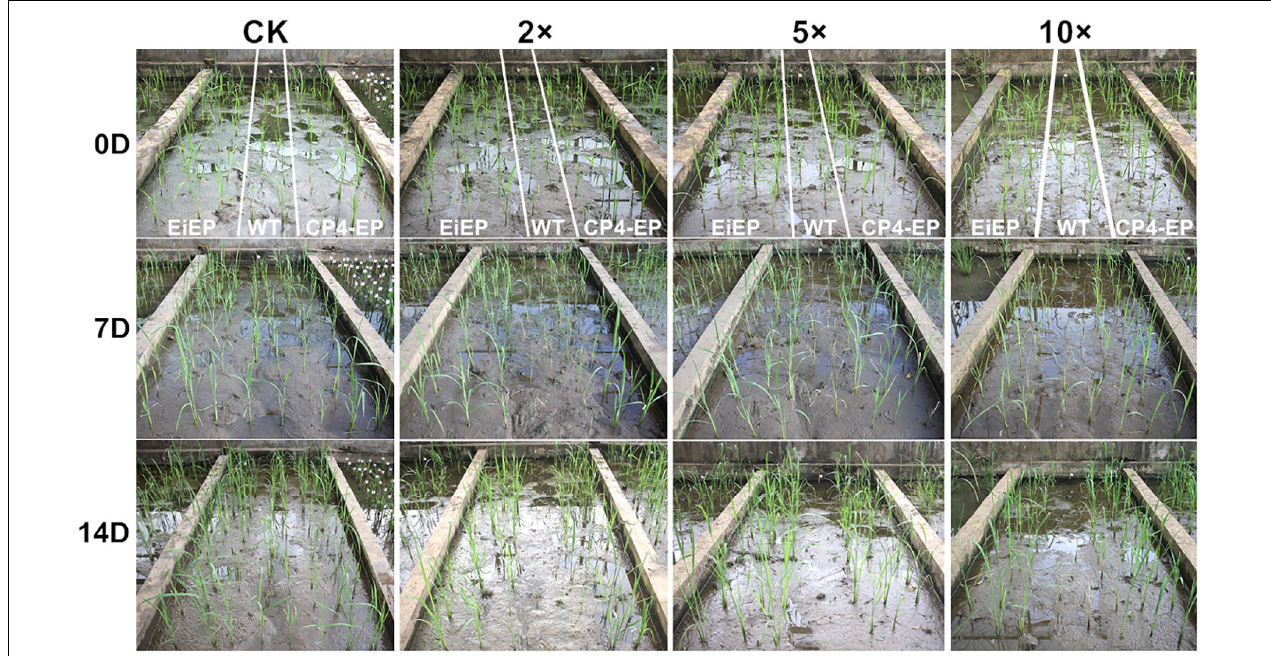
FIGURE 4 | Field test of the glyphosate resistance in the pCEiEPSPS and pCP4-EPSPS T 1 transgenic plants. The seeds from the pCEiEPSPS and pCP4-EPSPS T 1 transgenic plants were germinated under glyphosate selection and the seedlings were transplanted in the field with three lines and the WT plant were planted with two lines between them (showed between the white lines). After about 2 weeks of being transplanted in the field, the plants were treated with 0, 0.225 (2 × ), 0.5625 (5 × ), or 1.125 (10 × ) g a.e./m 2 . The phenotypes were recorded at 7 and 14 days after being sprayed. All the WT plants died at 14DAT while the pCEiEPSPS and pCP4-EPSPS T 1 transgenic plants grew normally. CK, plants without glyphosate treatment; EiEP, pCEiEPSPS T 1 transgenic lines; CP4-EP, pCP4-EPSPS T 1 transgenic